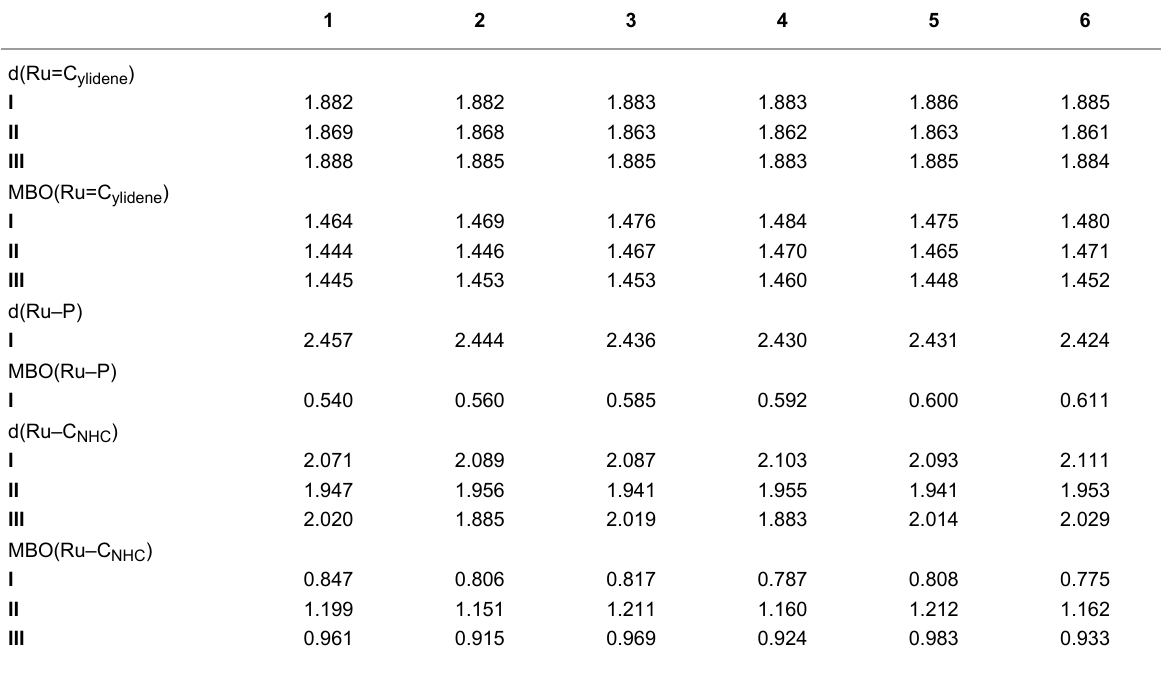
Table 2: Structural analysis for species I – III for catalysts 1 – 6 (in kcal/mol), including selected bond distances (d) in Å and Mayer Bond Orders (MBO). 1